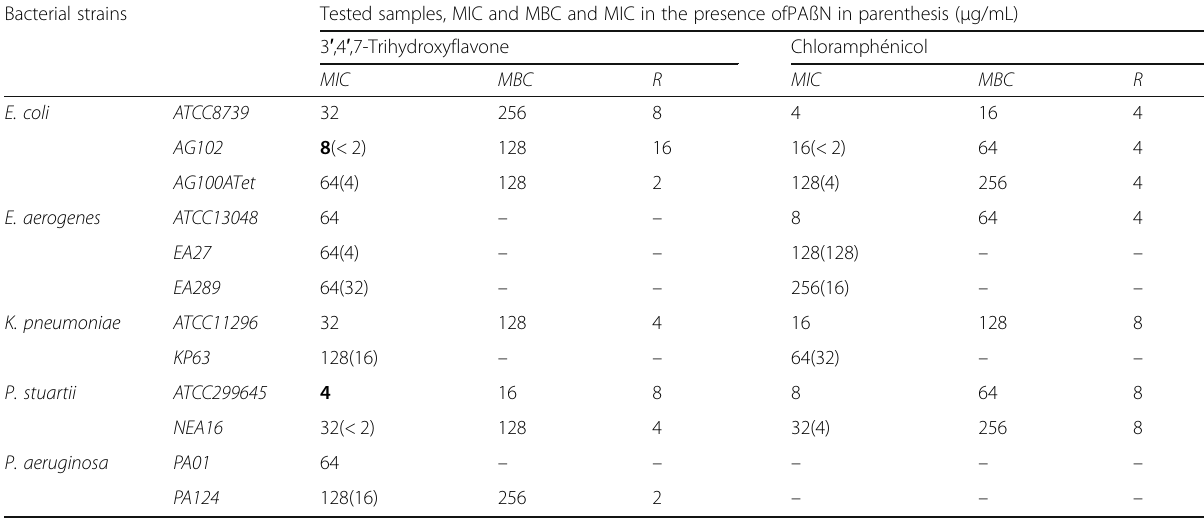
Table 2 Minimal Inhibitory Concentration (MIC) in μ g/mL of isolated compounds and chloramphenicol Bacterial strains Tested samples, MIC and MBC and MIC in the presence ofPAßN in parenthesis ( μ g/mL) 3 ′ ,4 ′